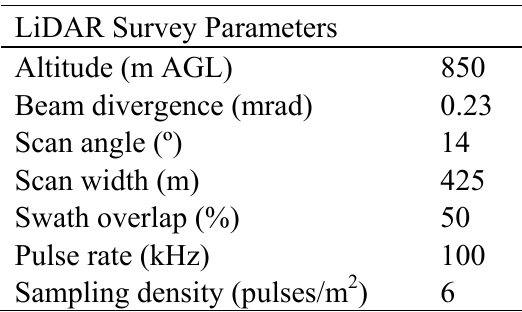
Table 1. Flight and sensor